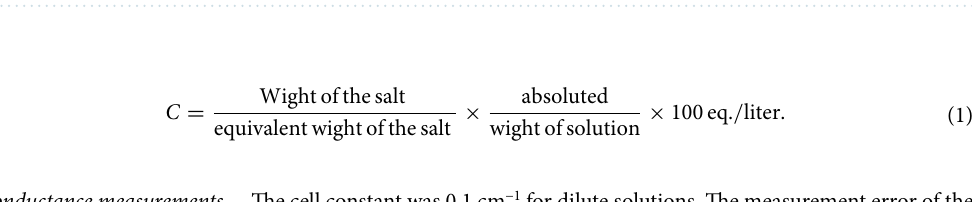
Table 1. Solvent parameters of Dimethylformamide at 25, 30, 35 and 40 °C and 1 atm.